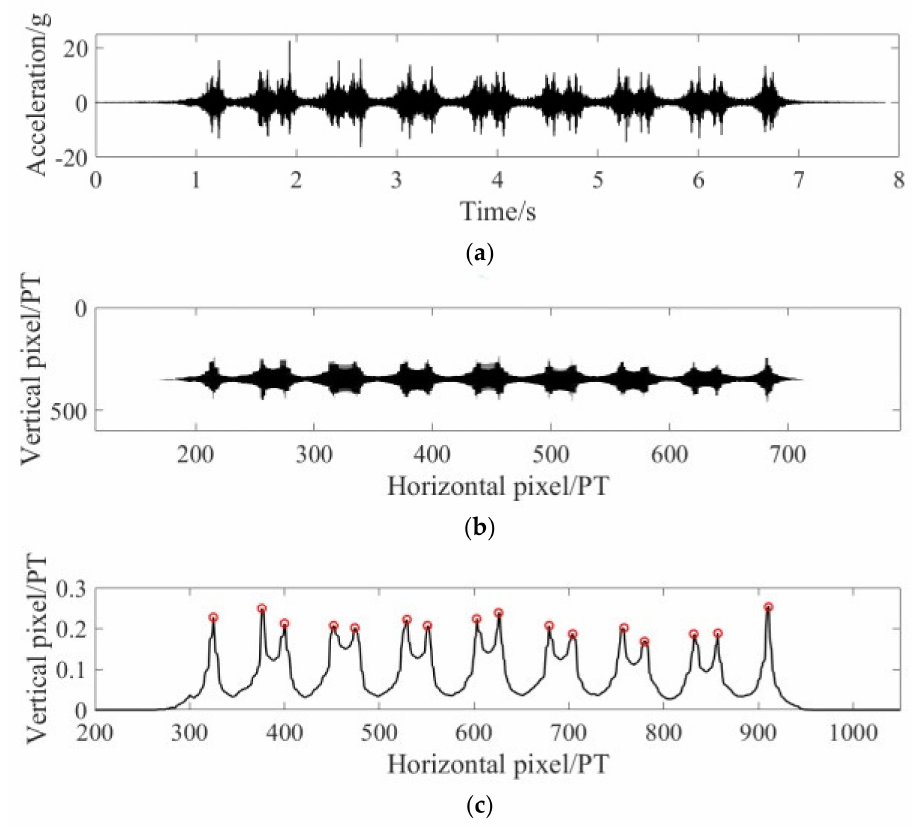
Figure 6. Diagrams of image treatment process: ( a ) the high-frequency D 1 signal recombination waveform diagram; ( b ) the corrosive operated waveform diagram; ( c ) the gray vertical projection and the signal feature extraction